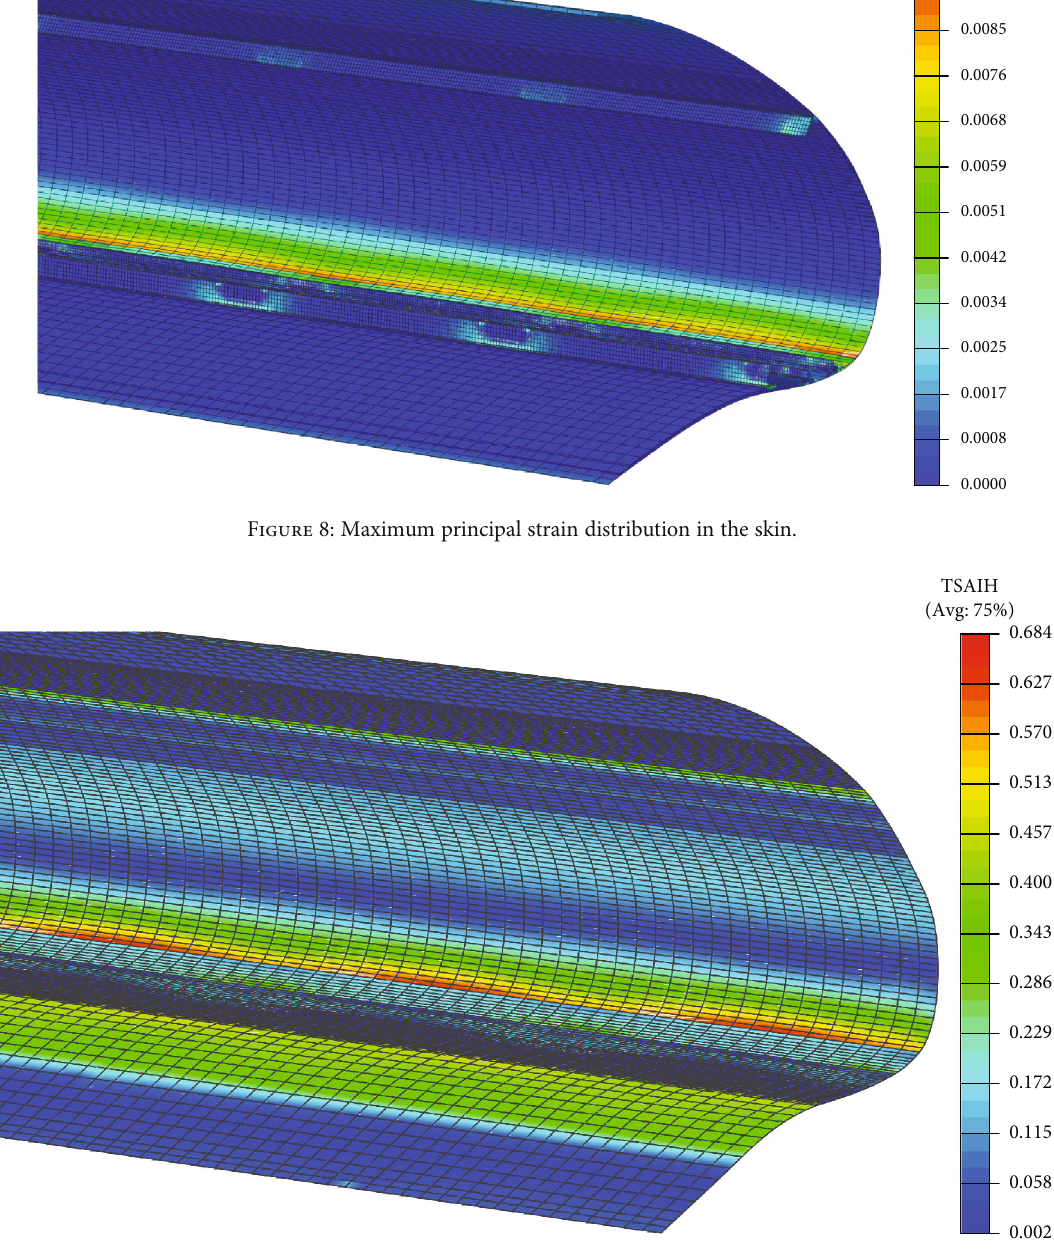
Figure 9: Strain veri fi cation for the skin: failure index distribution based on the Tsai-Hill theory.